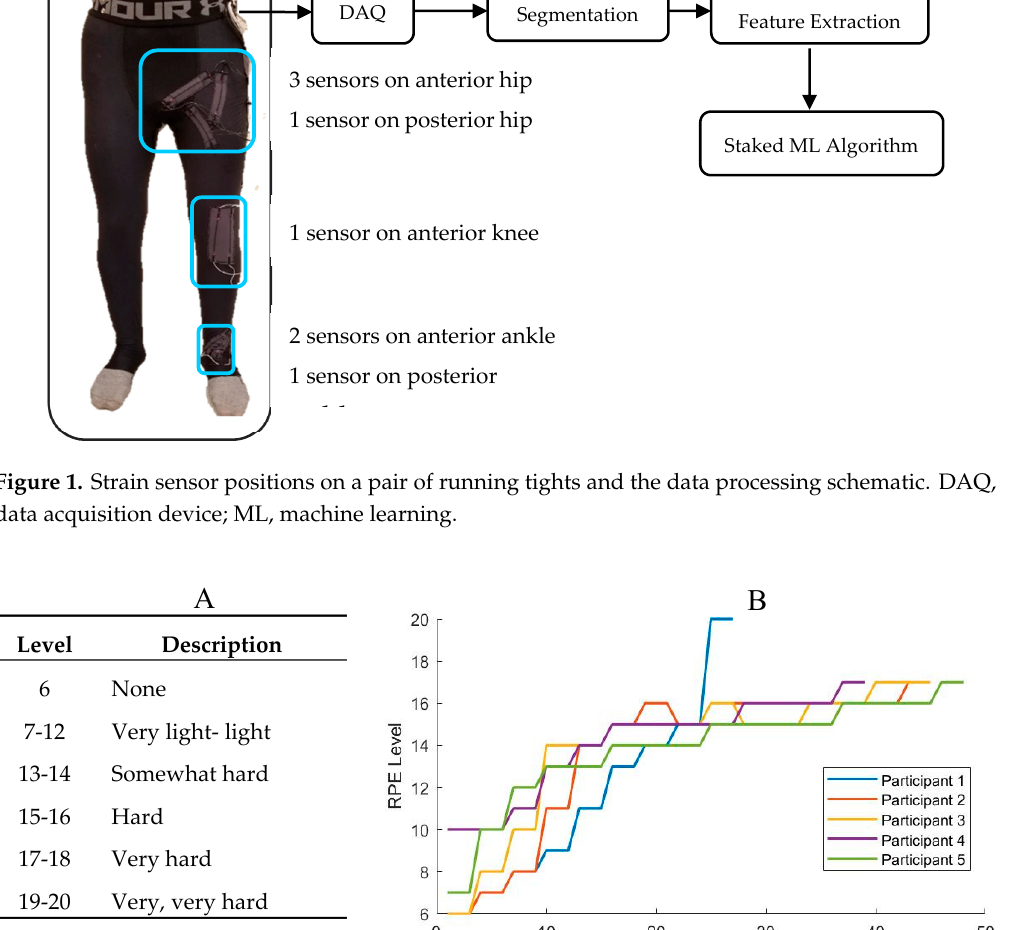
Figure 1. Strain sensor positions on a pair of running tights and the data processing schematic. DAQ, data acquisition device; ML, machine learning.